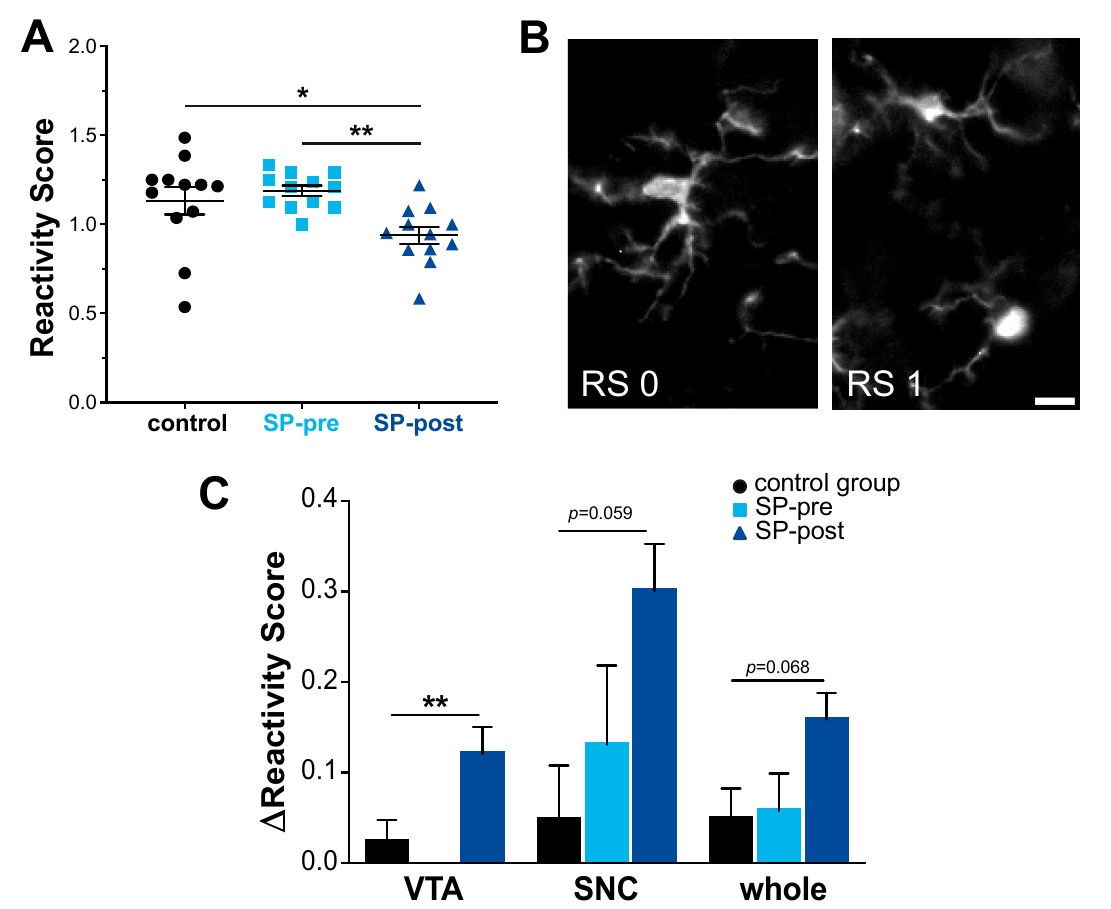
Figure 4. Microglial activation in the midbrain was not increased by Substance P. ( A ) Quantitative between-group comparison of overall ventral midbrain microglial reactivity scores (RS) after stroke (ipsilesional + contralesional hemisphere) indicates lowest values for SP-animals. ( B ) Representative microscopy image (10 × magnification) illustrating different states of activation (RS 0 and RS 1) in Iba1-immunoreactive microglia. ( C ) Between-group assessments of ∆ RS (RS ipsilesional – RS contralesional) indicate that a relevant ipsilesional increase in microglial activation was only present in SP-post animals. SNC: substantia nigra pars compacta, VTA: ventral tegmental area,